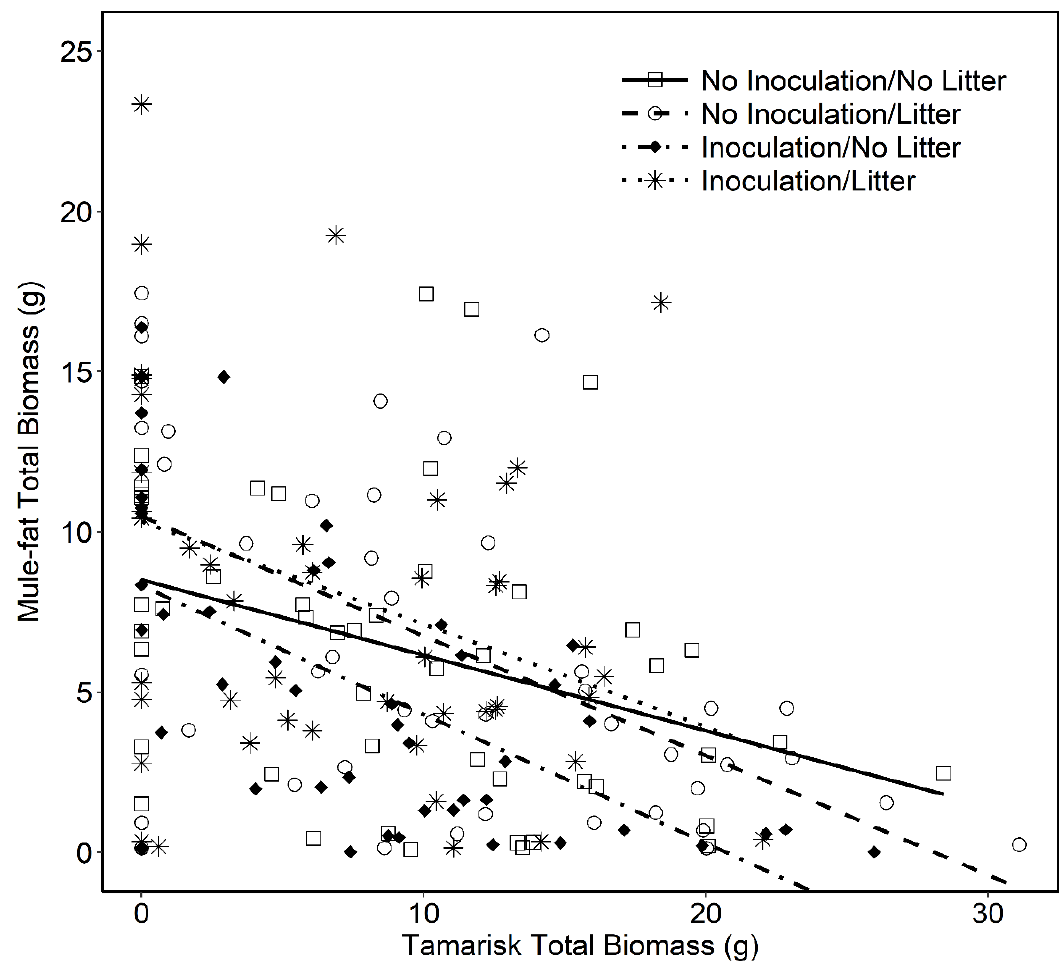
Figure 1. Mule-fat ( Baccharis salicifolia ) biomass response to tamarisk ( Tamarix chinensis ) biomass in competition experiments, with and without a mycorrhizal inoculant and tamarisk litter. Regression lines are based on final measured biomass of each species.